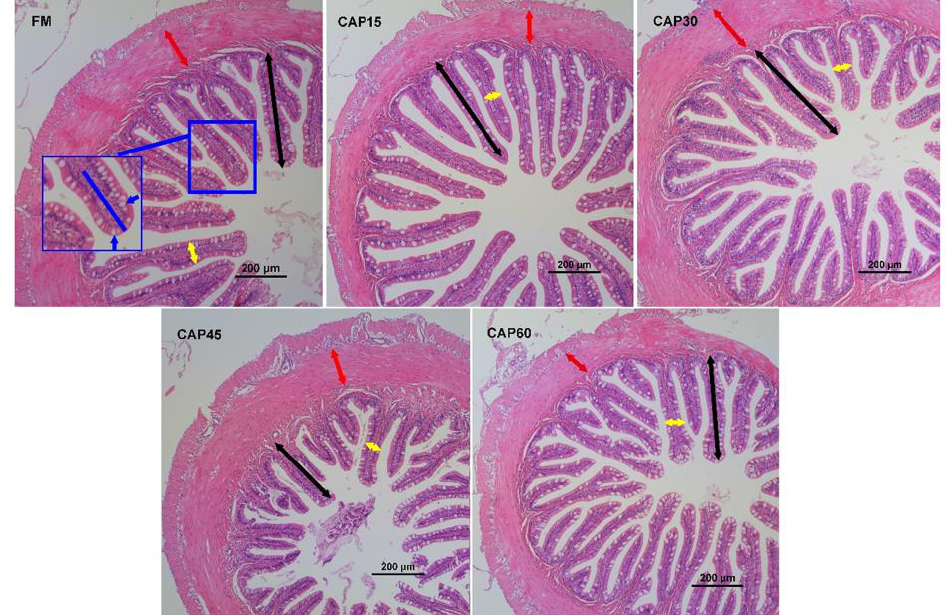
Figure 1. HE-stained sections of distal intestines of pearl gentian grouper fed gradient substitution of fishmeal in the diet with CAP (magnification = 40, Scale size = 50 μm).